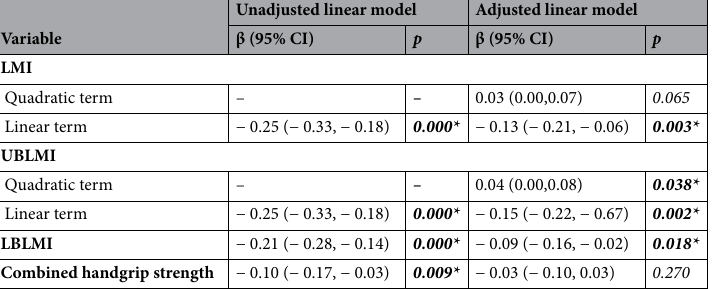
Table 4. Standardised linear effects of sex hormone binding globulin (SHBG) on lean mass index (LMI), upper body lean mass index (UBLMI), lower body lean mass index (LBLMI) or combined handgrip strength in 18–40-year-old females (n = 716). *denotes statistical significance ( p <